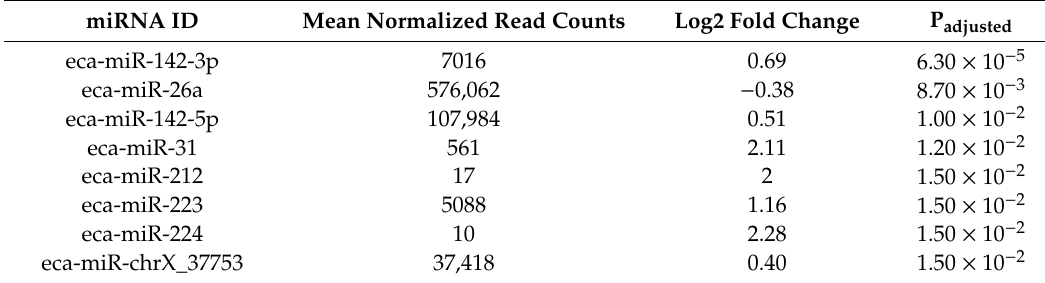
Table 3. Di ff erentially expressed miRNAs comparing horses in an exacerbated state and control horses. The mean DESeq2 normalized read counts, the log2 fold change, and the adjusted p -values are indicated. miRNA ID Mean Normalized Read Counts Log2 Fold Change P adjusted